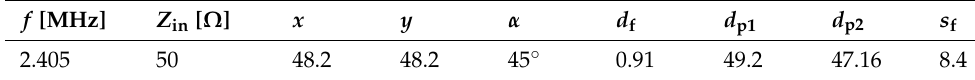
Table 1. Dimensions of designed patch (distances are in millimeters).